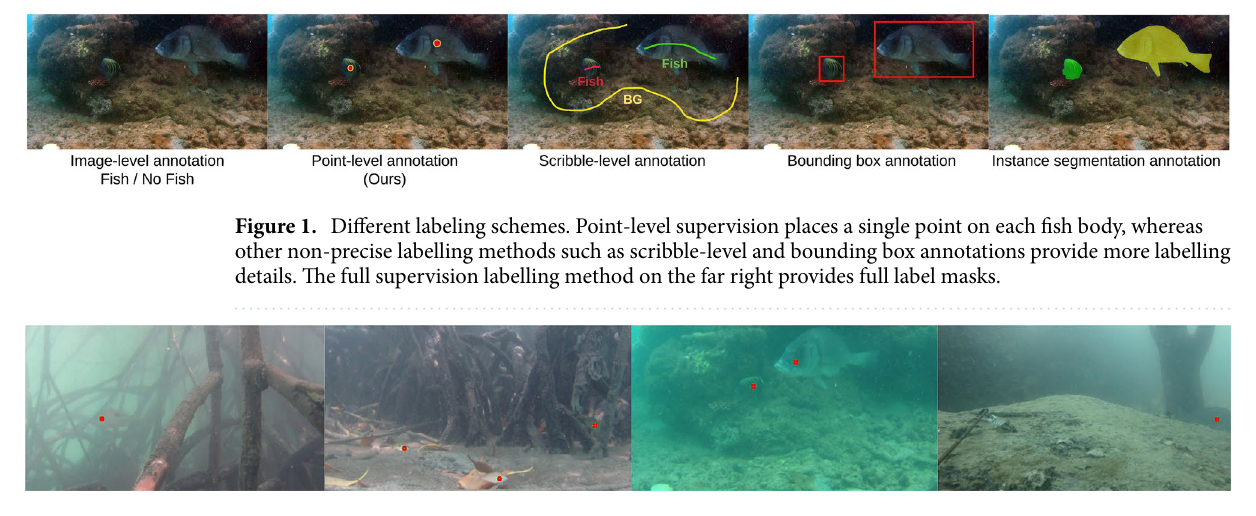
Figure 2. DeepFish dataset. Images from different habitats with point annotations on the fish (shown as red dots). These images are from the open-source DeepFish dataset available at https:// alzay ats. github. io/ DeepF